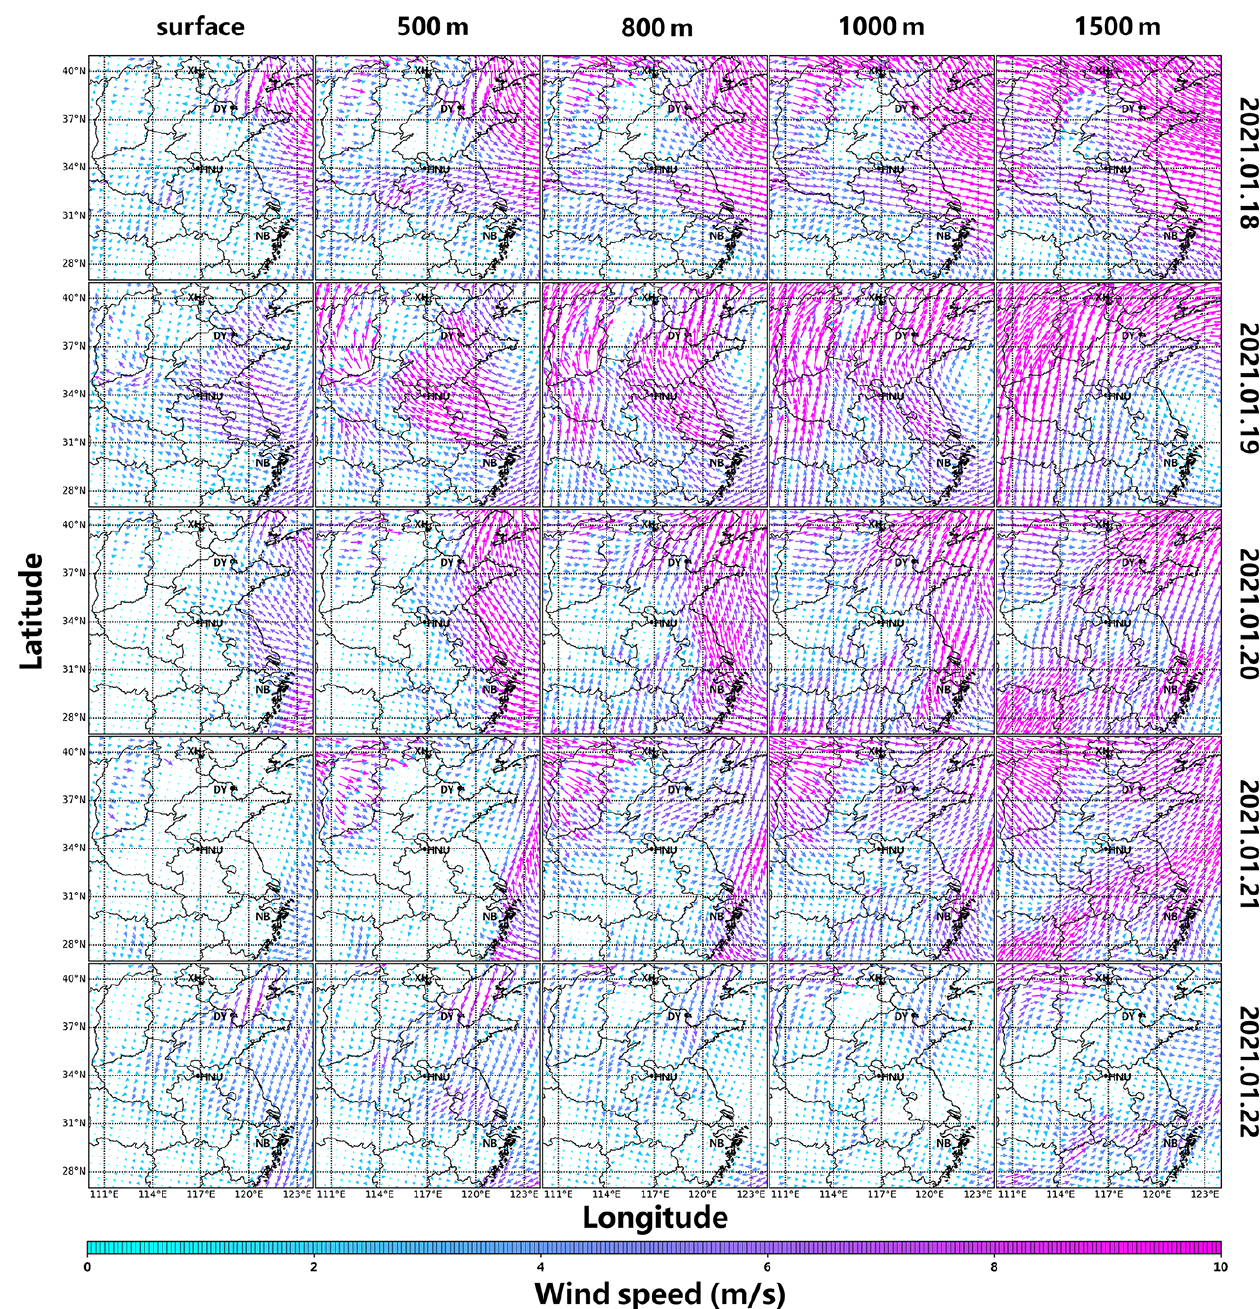
Figure 8. Wind fields in layers of surface, 500, 800, 1000, and 1500m at 12:00 from 18 to 22 January